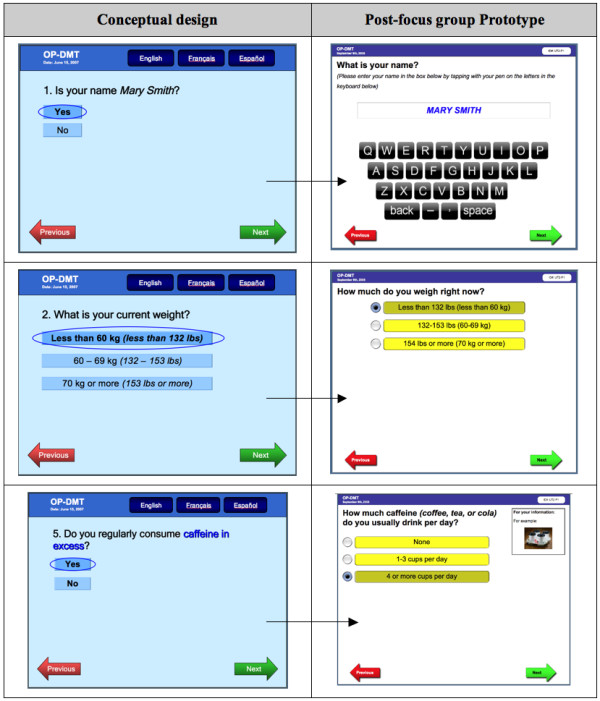
Screen shots of the evolution of selected Risk Assessment Questionnaire (RAQ).